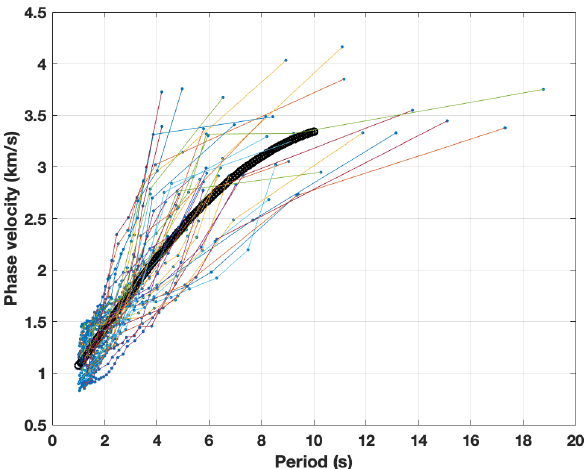
Figure 7. The picked phase velocity of every station pair is shown as colored lines. Blue circles are all the picked phase velocities. The thick black curve gives the average dispersion curve of all the picked data up to a maximum of 10 s.